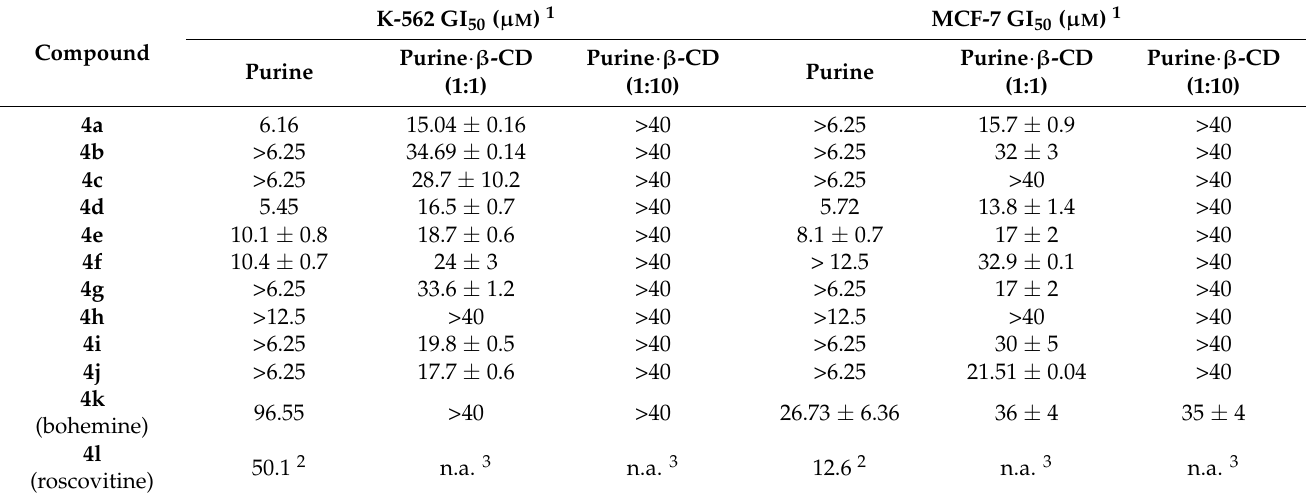
Table 2. In vitro antiproliferative activity of purines 4a – l and their complexes with β -CD. K-562 GI 50 ( µ M ) 1 MCF-7 GI 50 ( µ M ) 1 Compound Purine · β Purine